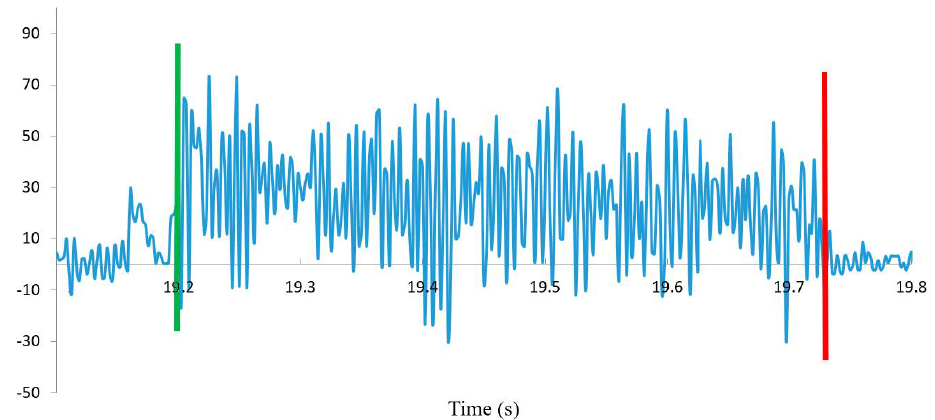
Figure 3. Diagram of the dependence of the horizontal component of the cutting force of one cutting element on time.